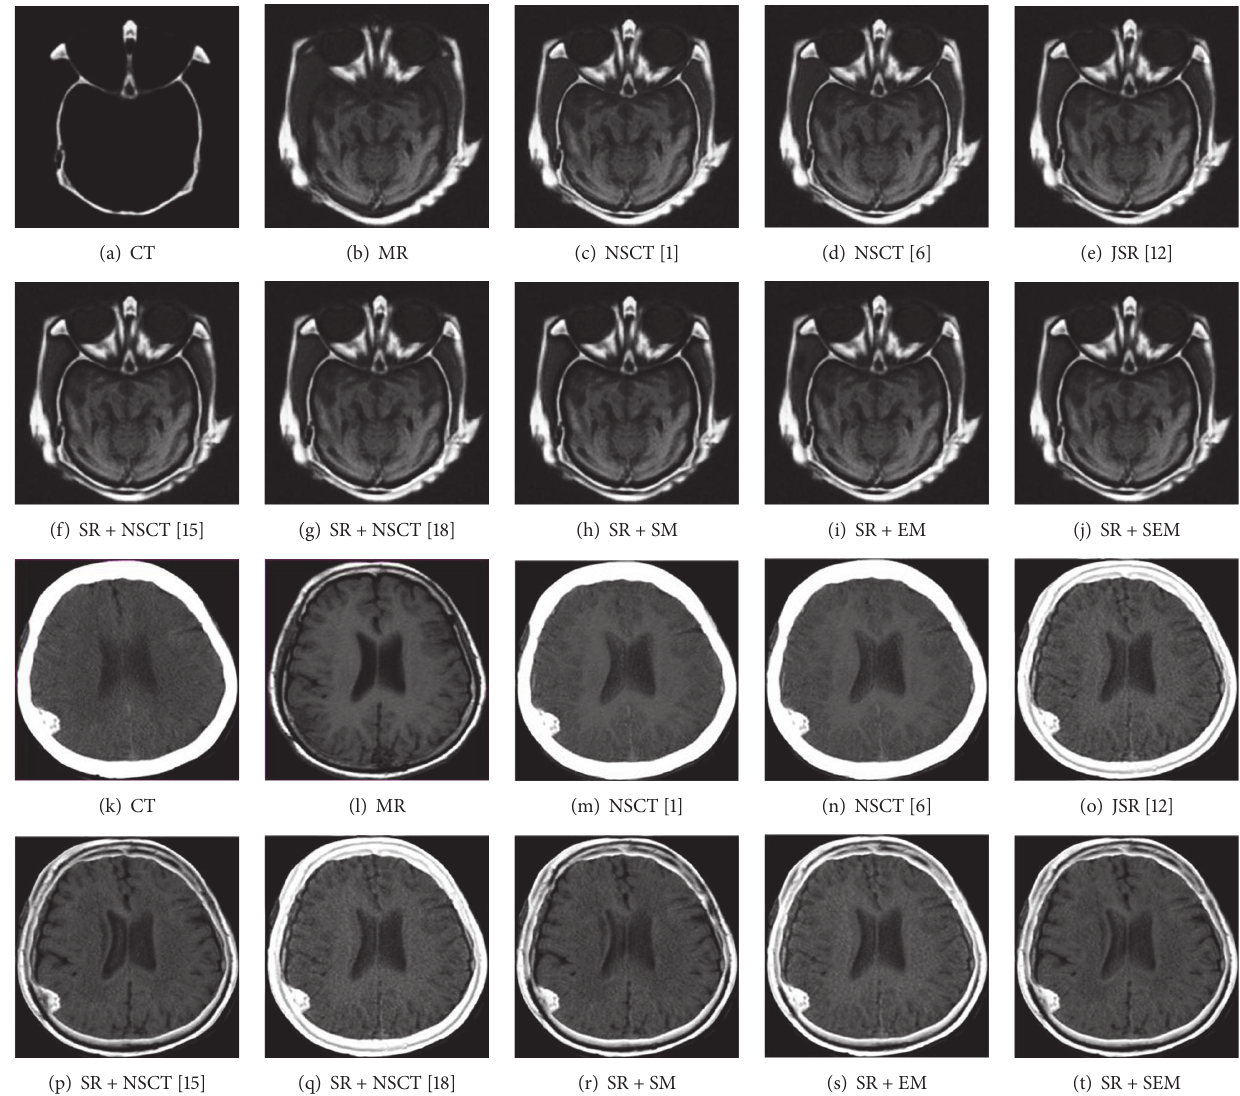
Figure 5: The CT and MR image fused results of different fusion